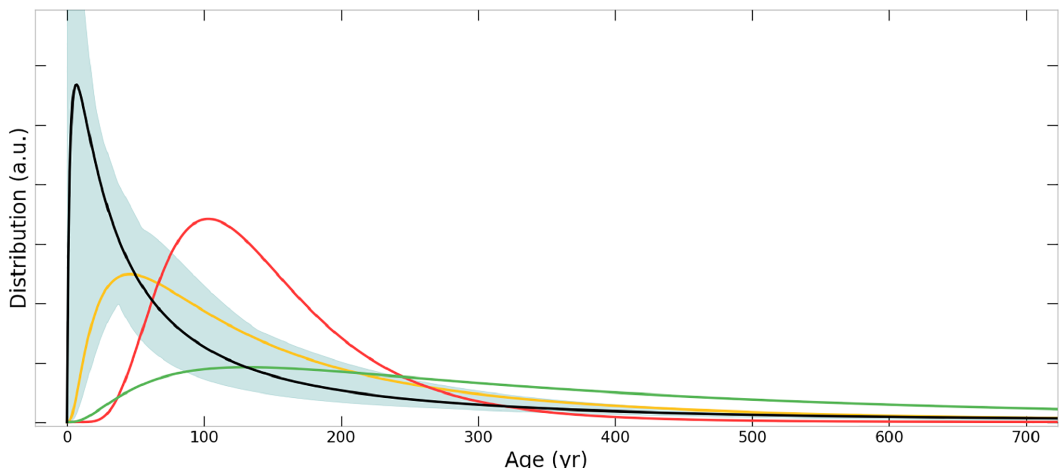
Figure 6. Gas age distributions. In black: the Vostok GAD during the DO-17 estimated with our optimization scheme; the uncertainty envelope is shown in light blue. In yellow: a lognormal fit to the modern-condition Vostok GAD from Witrant et al. (2012). In red: the estimated Dome C GAD during B/A from Köhler et al. (2015). In green: the estimated Dome C GAD during LGM from Köhler et al. (2011).